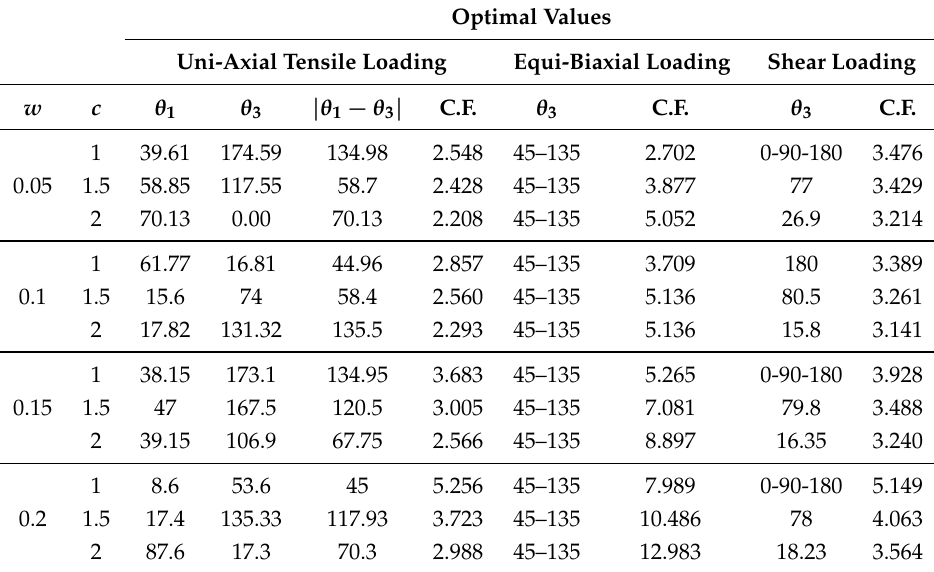
Table 5. Optimal results for rectangular cutout in isotropic